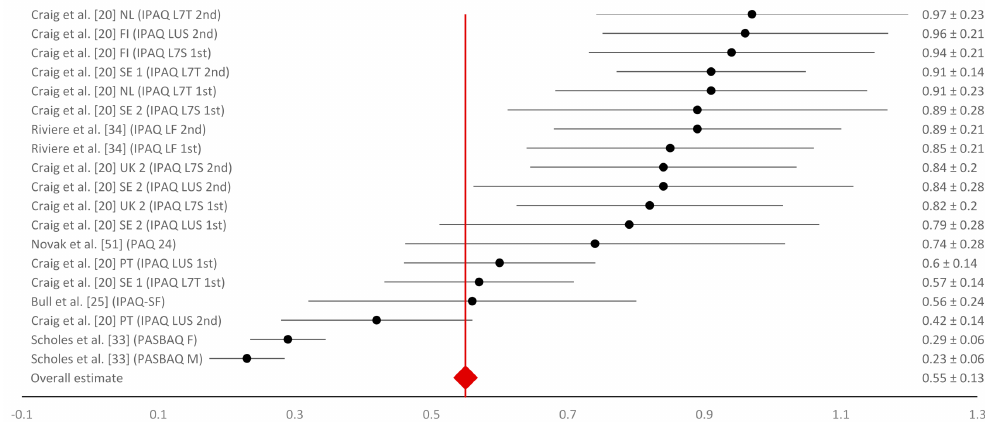
Figure 3. Forest plot of concurrent validity coefficients with 95% confidence intervals. Notes: B—Belgium; FI—Finland; FR— France; NL—The Netherlands; PT—Portugal; SE—Sweden; UK—United Kingdom; PAQ 24—Physical Activity Questionnaire for 24 h; PASBAQ—Physical Activity and Sedentary Behaviour Assessment Questionnaire; M—male;